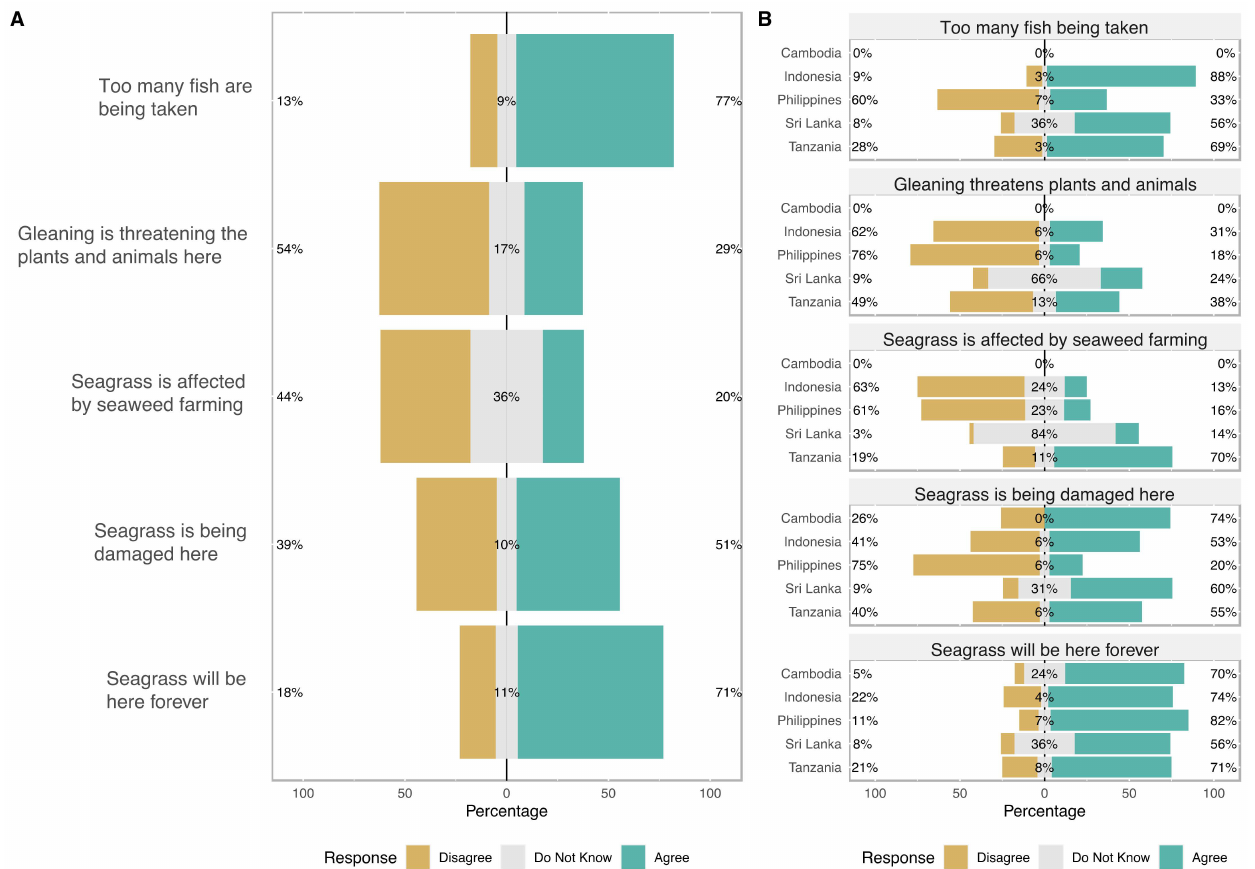
Figure 4. Consensus statements related to the effects of coastal resource use in the Indo-Pacific region: ( A ) across the whole dataset; ( B ) across each country. Respondents were presented five statements relating to fishing, gleaning, and seaweed farming, as well as damage to seagrass and its persistence in the future. Responses could be categorized as either “agree”, “disagree”, or “do not know”. The numbers represent the proportion of respondents within each